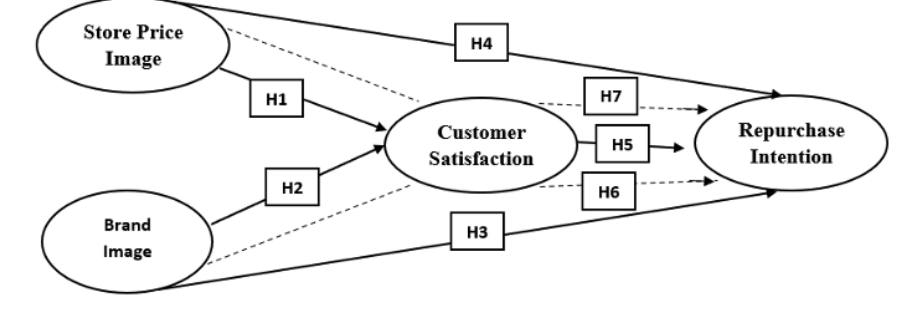
Figure 1: Research Framework and